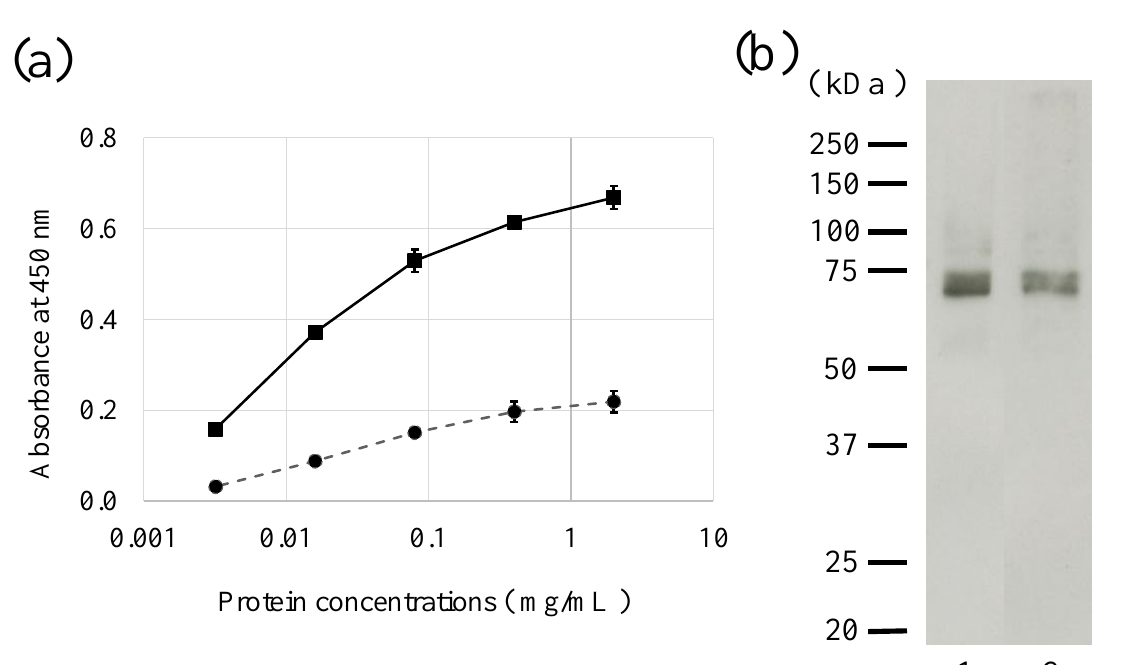
Figure 2. Detection of Gly m 7 using raised anti-Gly m 7 antibodies and horseradish peroxidase-labeled streptavidin in soybean extracts. ( a ) Enzyme-linked immunosorbent assay (ELISA) results for detection of Gly m 7 using raised anti-Gly m 7 antibodies. Soybean extracts were immobilized on ELISA plates, and immunoreactions were performed using raised anti-Gly m 7 antibody ( × 1000 diluted) (solid line) and preimmune sera ( × 1000 diluted) (dashed line). ( b ) Detection of Gly m 7 using raised anti-Gly m 7 antibodies (lane 1) and horseradish peroxidase-labeled streptavidin (lane 2).